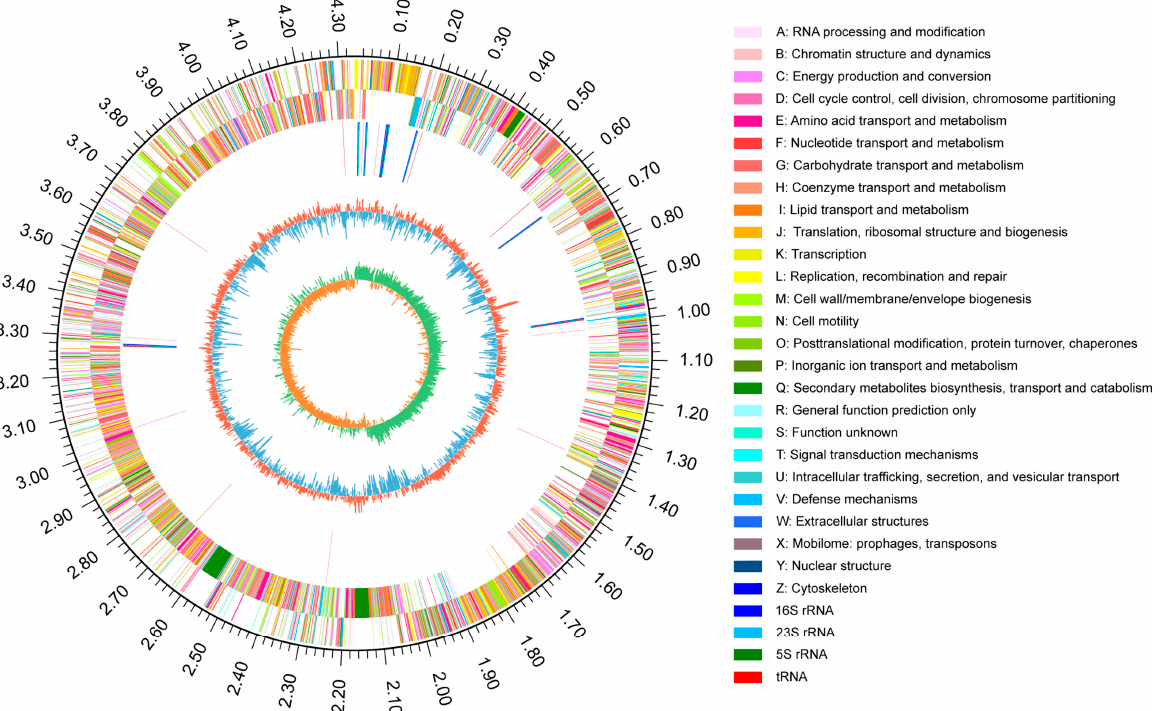
Figure 5. Schematic of the complete B. paralicheniformis RP01 genome. Rings represent the following features labeled from the outside to the center: The outermost circle represents the scale in bp. The second ring represents positive strand genes and the third ring represents negative strand genes. Each color patch represents a COG functional classification. The fourth ring represents rRNA and tRNA. The fifth ring represents the GC content (red indicates GC content above the mean, blue indicates GC content below the mean). The innermost ring shows the GC skew (GC skew = (G − C)/(G + C); green means greater than 0, orange means less than 0).